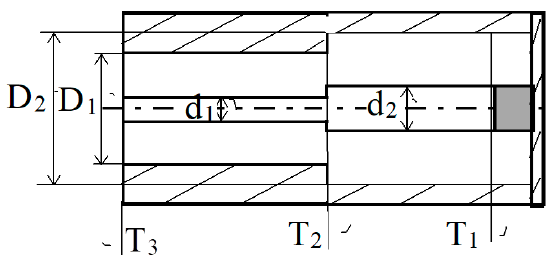
Figure 2. The scheme of coaxial load.